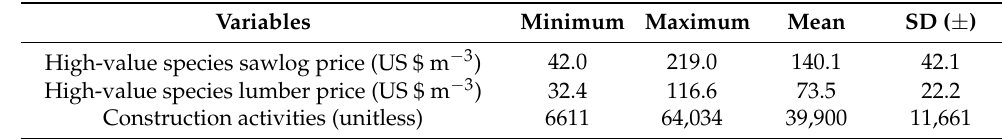
Table 1. Descriptive statistics of time series variables, including sawlog and lumber price and construction activities (number of residential